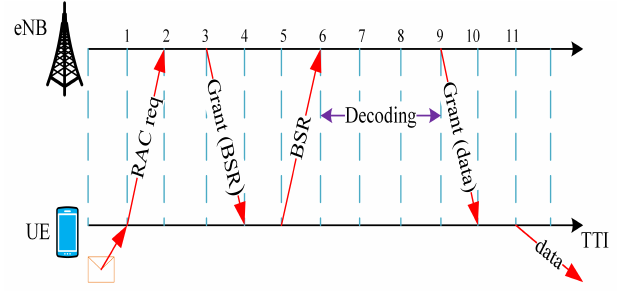
Figure 4. Resource allocation in SRA, Mode 3.